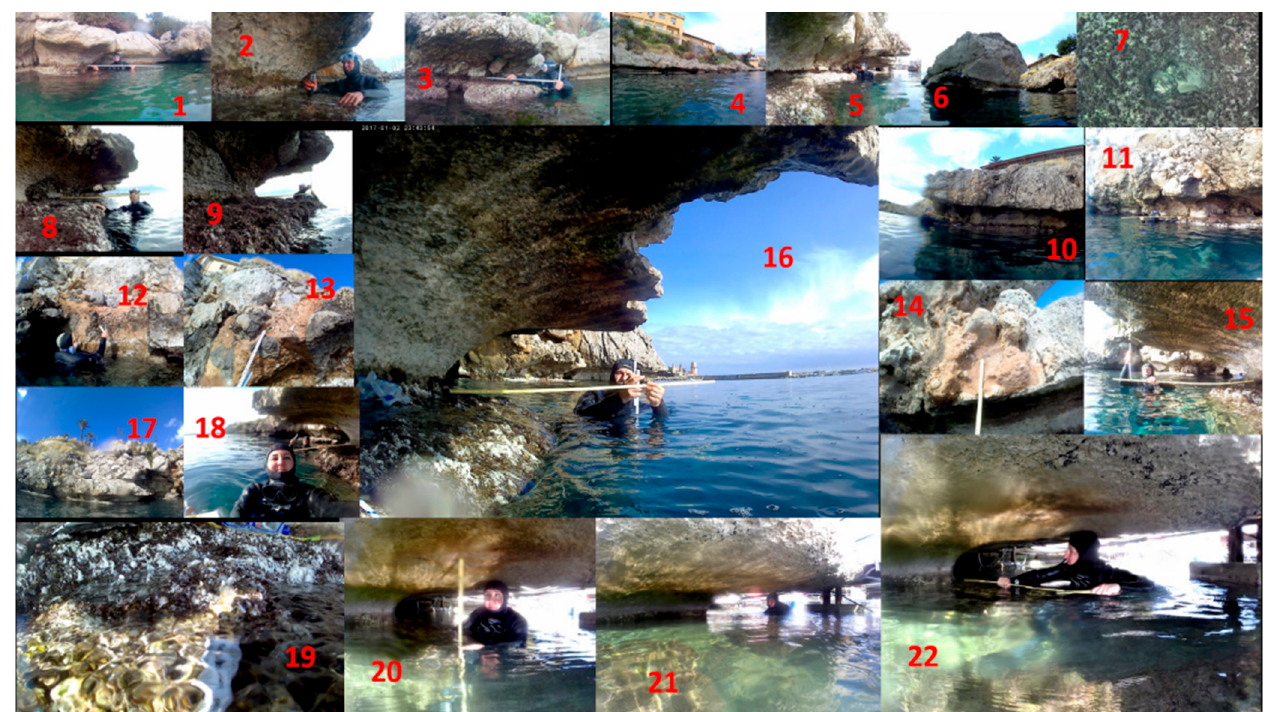
Figure 11. Collection of MTN images observed and measured in Palermo. The numbers in the pictures are related to the numbers in Table 3.